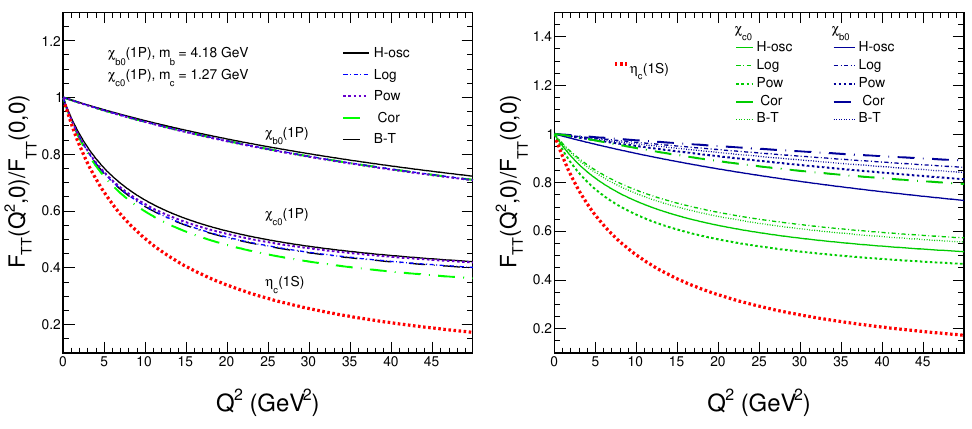
Figure 7 . Normalized to unity TT form factor for three di(cid:11)erent mesons: (cid:17) c (1S), (cid:31) c 0 (1P), (cid:31) b 0 (1P). 7 Di(cid:11)erential cross sections for the pp ! (cid:31)